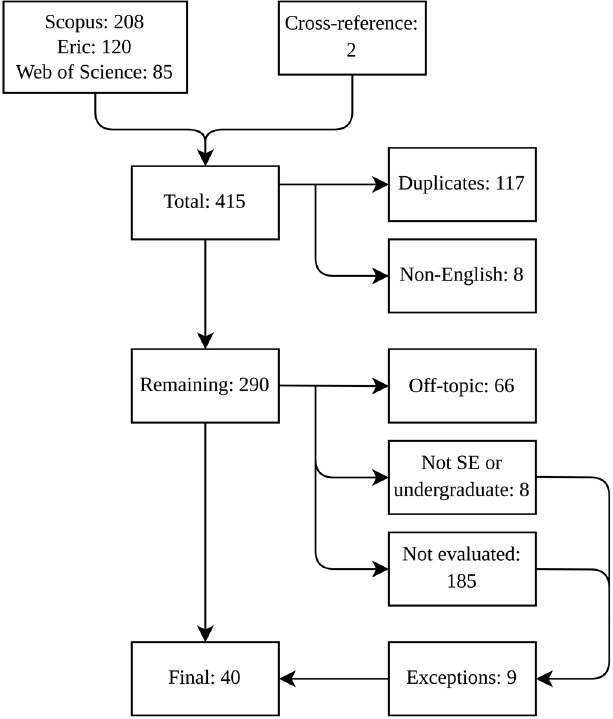
FIG. 1. A flow chart of the selection process, indicating the number of selected articles for each step. The abbreviation SE stands for secondary